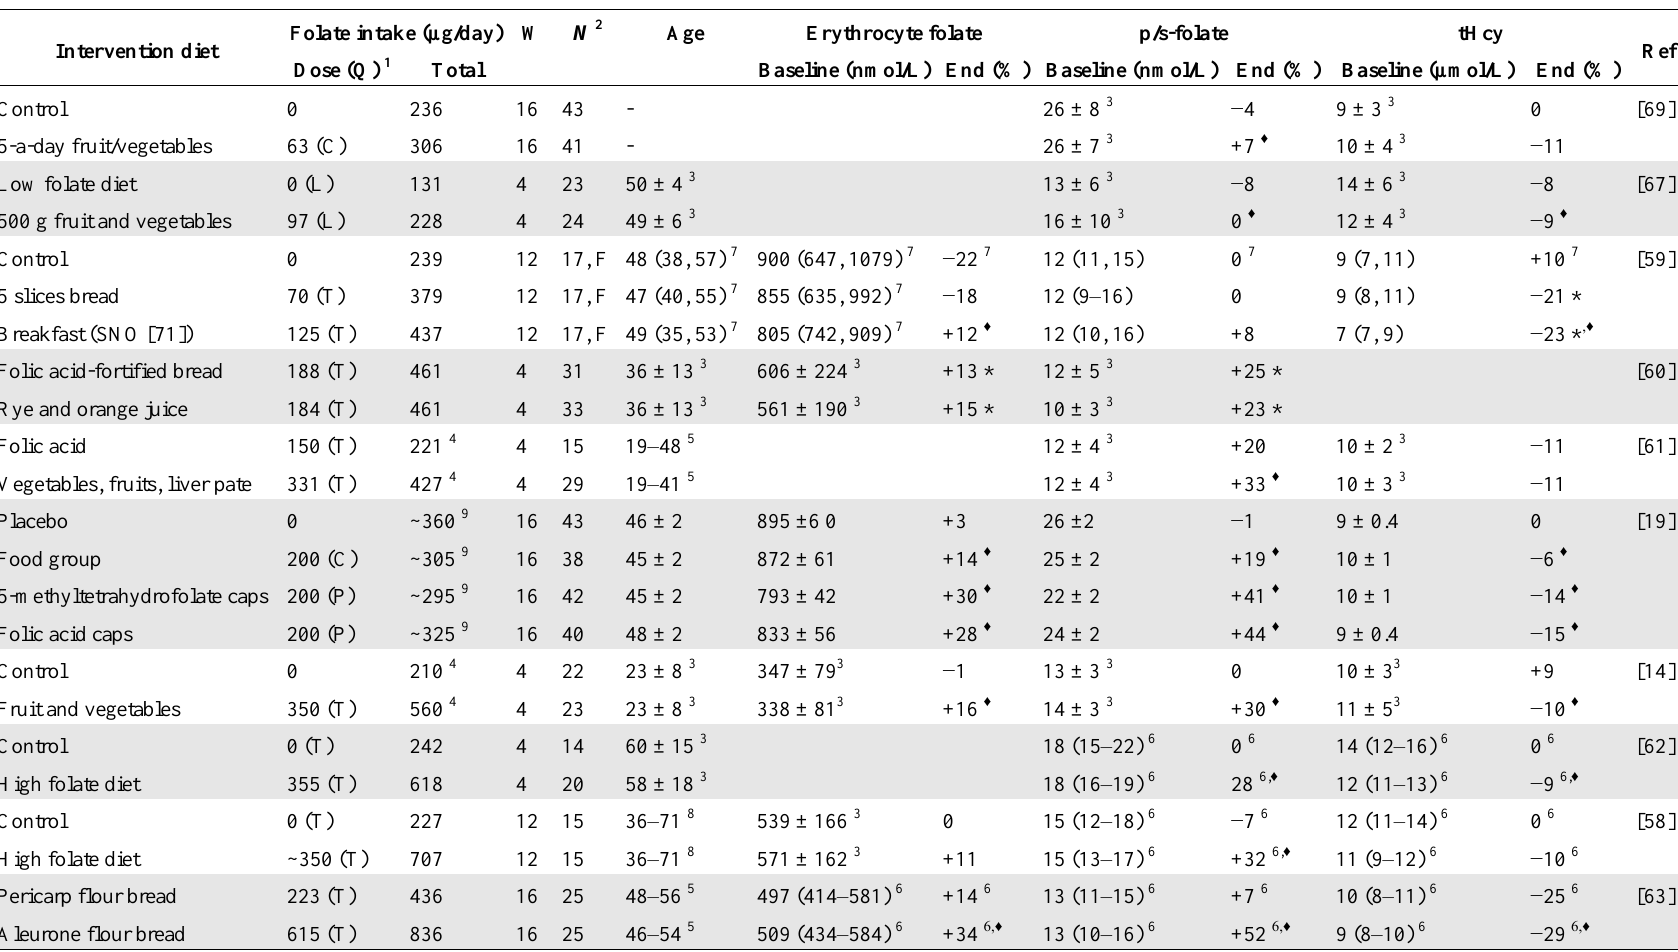
Table 2. Dietary folate intervention trials resulting in significant effects (presented as change (%) compared with baseline) on folate status. Intervention